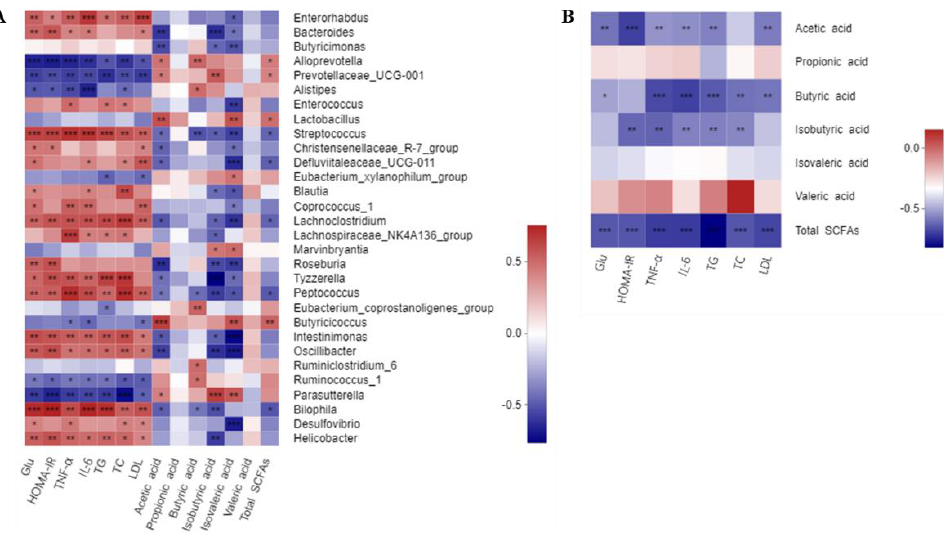
Figure 5. ( A ) Correlation between biochemical parameters and key communities of gut microbiota obtained from LEfSe results. ( B ) Correlation between biochemical parameters and SCFAs. Spearman’s correlation coefficients and p values for the correlations are calculated (* p < 0.05, ** p ≤ 0.01, *** p ≤ 0.001). A positive correlation is shown in red, and a negative correlation is shown in blue.